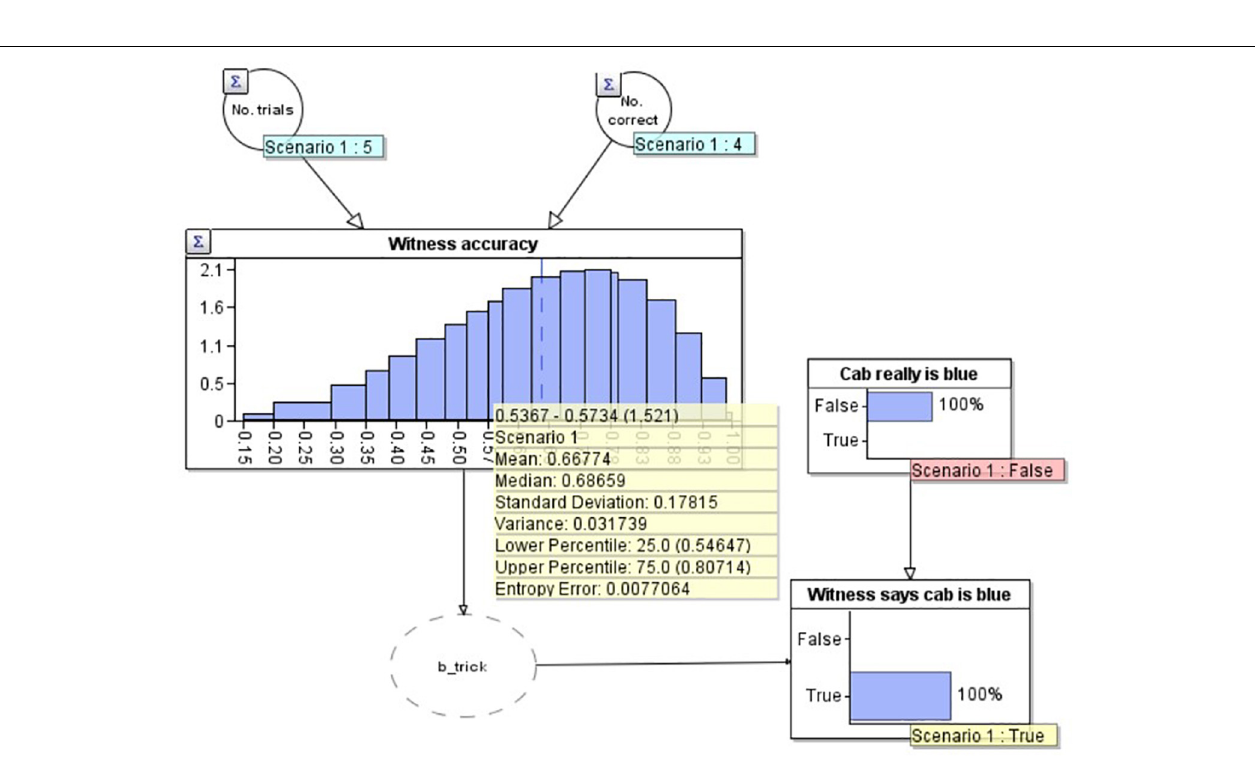
FIGURE 3 | A Bayesian network model depicting the situation where the witness is incorrect about the cab being blue.